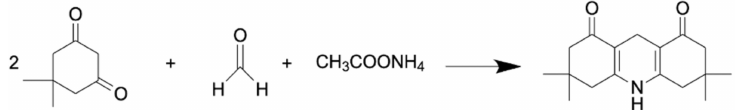
Figure 5. FA derivatization with